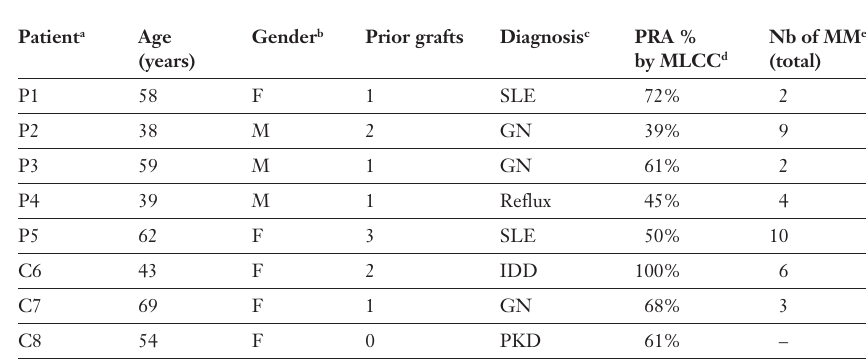
Table 1 Clinical characteris- tics of patients in- cluded in the study.